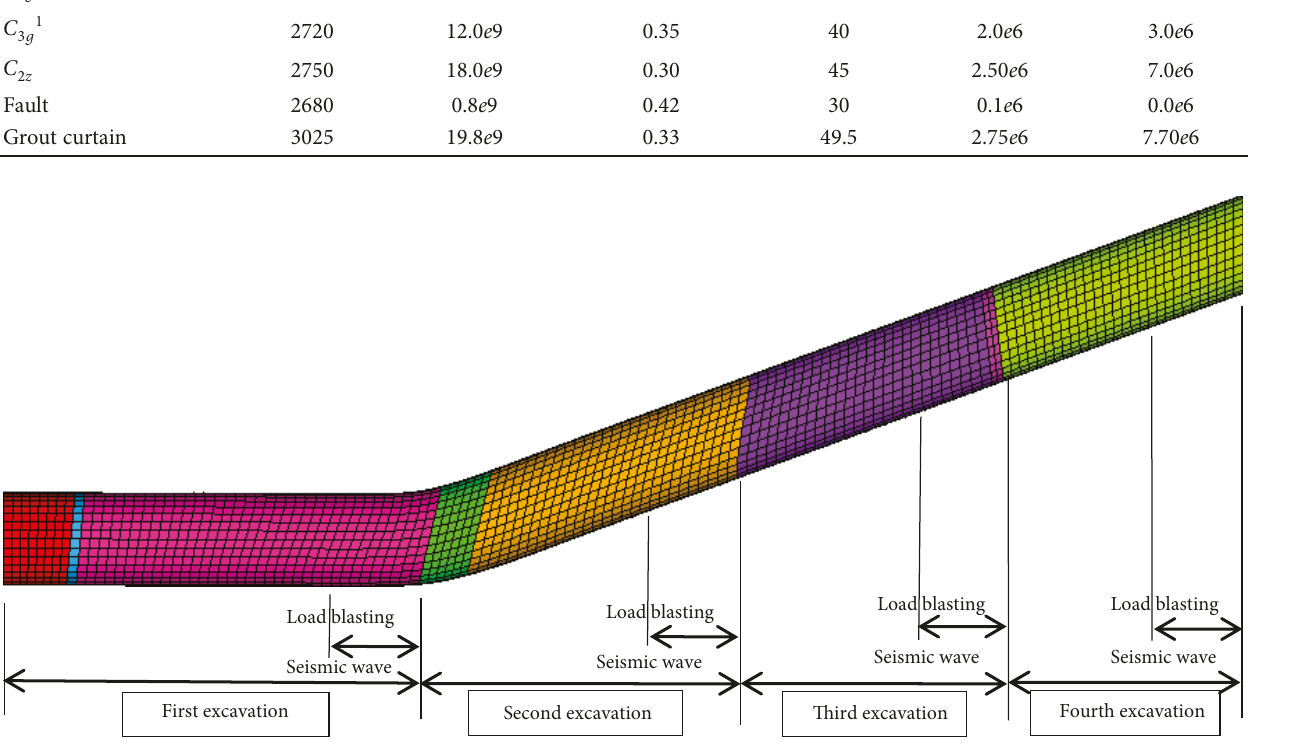
Figure 9: Segmented excavation and zoning of blasting seismic wave